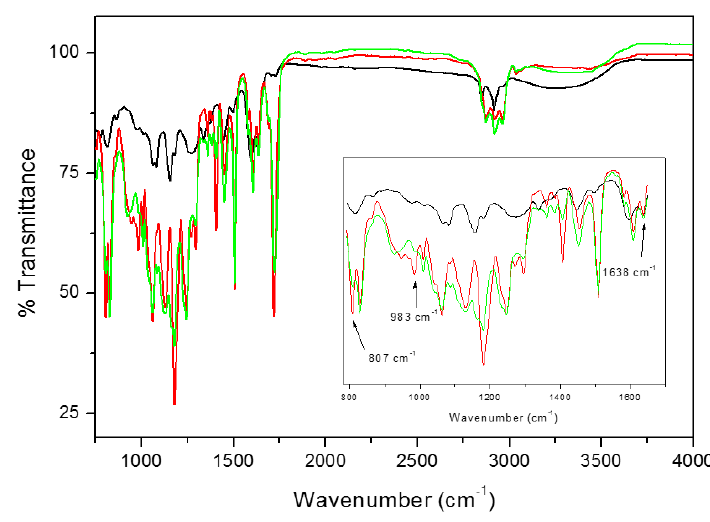
Figure 5. FTIR spectra of Taiwanese green propolis (TGP) powder (black line), EP10 before UV-curing (red line) and EP10 UV cured (green line). In the inset, the 790–1650 cm –1 region is zoomed. Table 2. Gathered values of T 10% , T max and the percentage of the residue at 700 ◦ C obtained from thermogravimetric analysis for neat Ebecryl resin, ET and EP